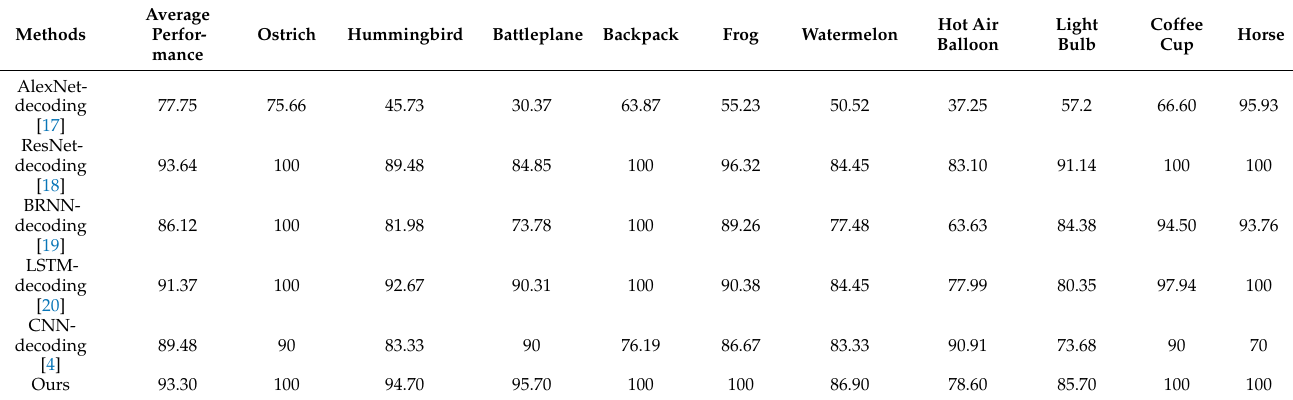
Table 6. Comparison of experimental results (F-Score,